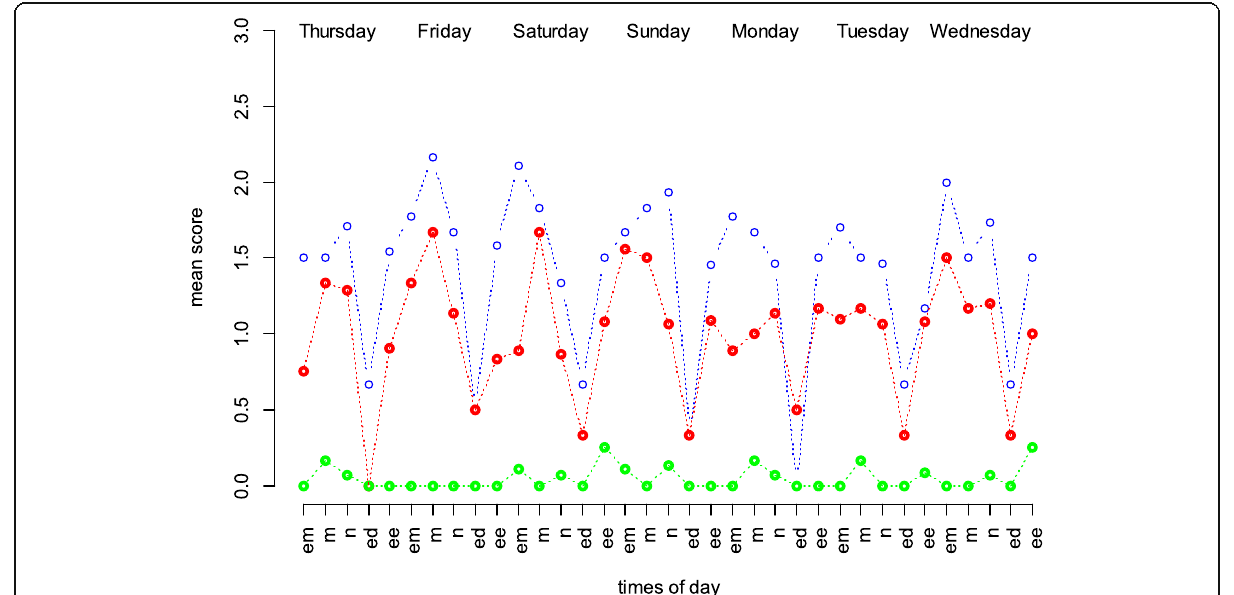
Fig. 1 Mean scores of street population density (blue), distancing (red), and masking (green) at various times of the day on each of the 7 days of the study (em, early morning; m, morning; n, noon; ed, end of the day; ee, early evening). The study was carried out between Thursday, 14